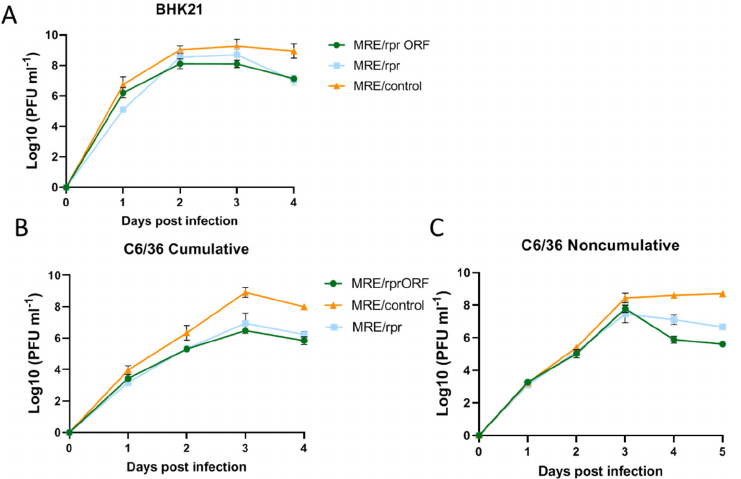
Figure 4. Virus replication curves in BHK-21 and C6/36 cells. ( A , B ) BHK-21 or C6/36 cells were infected with MRE/rprORF, MRE/rpr, or MRE/control at MOI 0.1 and a sample of supernatant was removed and titered by TCID 50 assay at each of the indicated time points. ( A ) In BHK-21 cells, MRE/rprORF ( p = 0.003) and MRE/rpr ( p = 0.0002) were significantly different compared to MRE/control. MRE/rpr and MRE/rprORF were not significantly different ( p = 0.9879). ( B ) In C6/36 cells, MRE/rprORF ( p < 0.0001) and MRE/rpr ( p < 0.0001) were significantly different compared to MRE/control. MRE/rprORF and MRE/rpr were not significantly different ( p = 0.7702). ( C ) Non-cumulative replication curve. C6/36 cells were infected with MRE/rprORF, MRE/rpr, or MRE/control at MOI 0.1. At each indicated time point, a sample of supernatant was removed for TCID 50 assay. The remaining cell culture medium was then removed from each well, the cells were rinsed, and the media was replaced. MRE/rprORF ( p < 0.0001) and MRE/rpr ( p < 0.0001) were significantly different compared to MRE/control. MRE/rprORF and MRE/rpr were also significantly different ( p = 0.0291). In ( A – C ), three independent biological replicates were performed. Titers were log transformed and compared with two-way ANOVA and Tukey’s multiple comparison test. Error bars represent